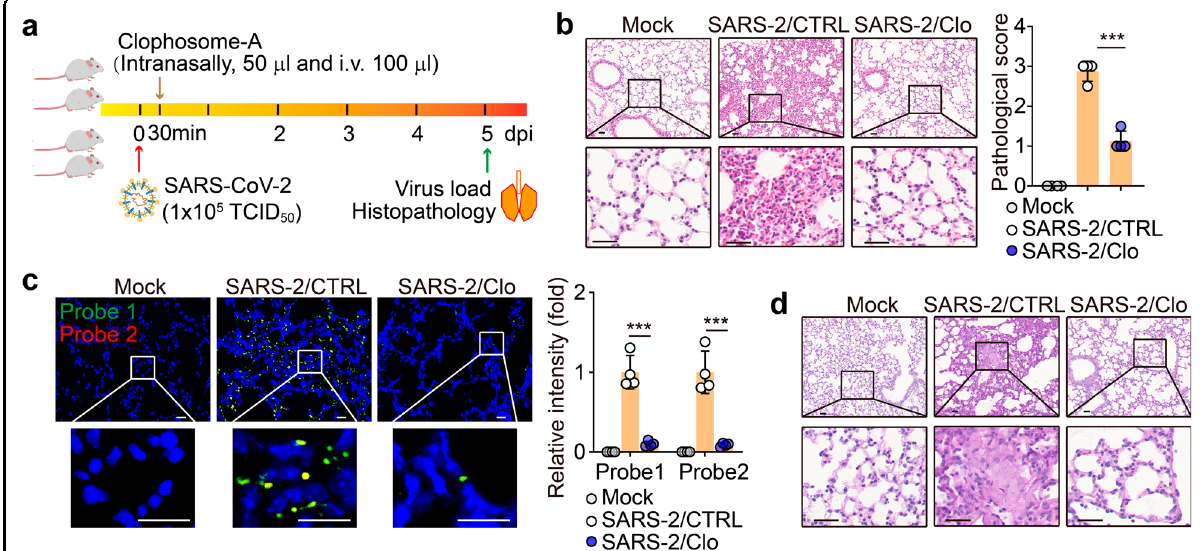
Fig. 6 Macrophages depletion attenuated lung damage induced by SARS-CoV-2 in vivo. a – d hACE2 transgenic mice were infected with SARS- CoV-2 for 30 min, and then administered with a control liposome (CTRL) or clophosome-A (intranasally, 50 μ L and i.v. 100 μ L) once. The schematic diagram of the experimental design was shown ( a ). The lung tissues were performed the H&E staining ( b ), RNAscope analysis with probe 1 (green color, targeting the positive-sense sequence) and 2 (red color, targeting the negative-sense sequence) ( c ) or PAS staining ( d ). Three lung sections from the left lobe were evaluated for each mouse. The representative image re fl ected the distributions of damaged lung tissues. Scale bar, 20 μ m for c , 50 μ m for b , d . The data represent mean ± SD. n = 4. *** P < 0.001, by one-way ANOVA ( b , c